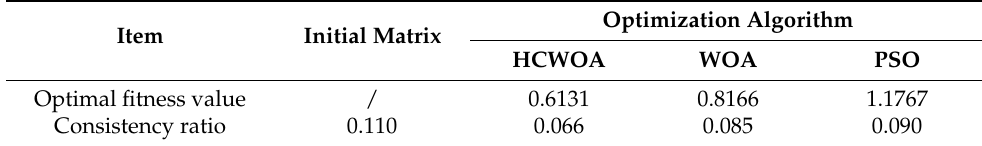
Table 15. Result of comparative experimental analysis. Item Initial Matrix